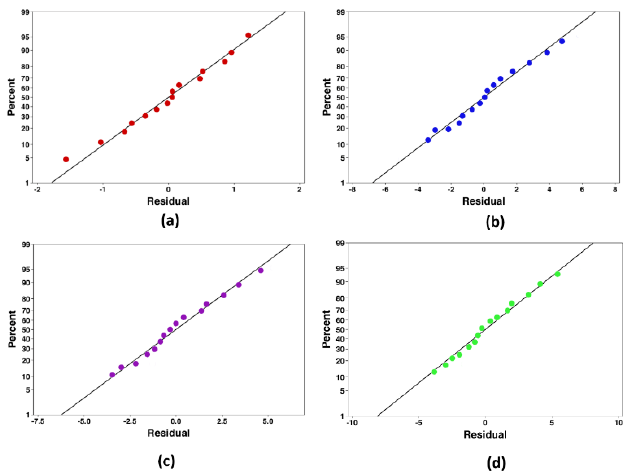
Figure 6. Normal probability plot of the residuals for the heat transfer coefficient (HTC), ( a ): φ = 0%, ( b ): φ = 1%, ( c ): φ = 3%, and ( d ): φ = 5%.